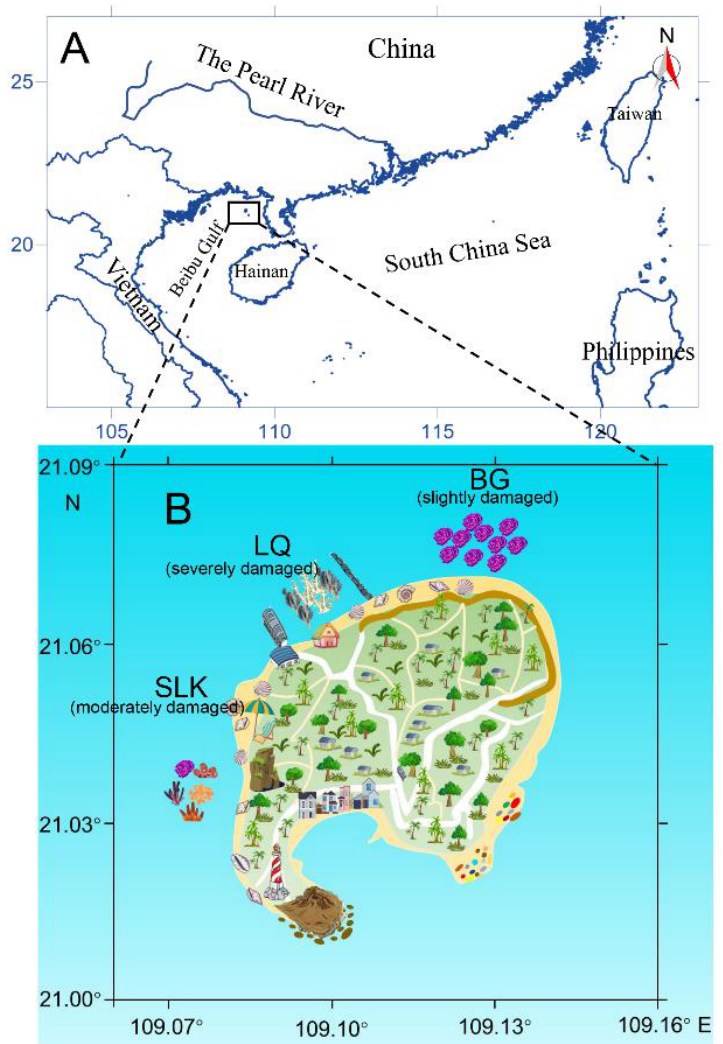
Figure 1. Map of sampling locations. ( A ) Location of Weizhou Island in the Beibu Gulf, South China Sea. ( B ) Map of Weizhou Island, showing the sampling locations (sites BG, LQ and